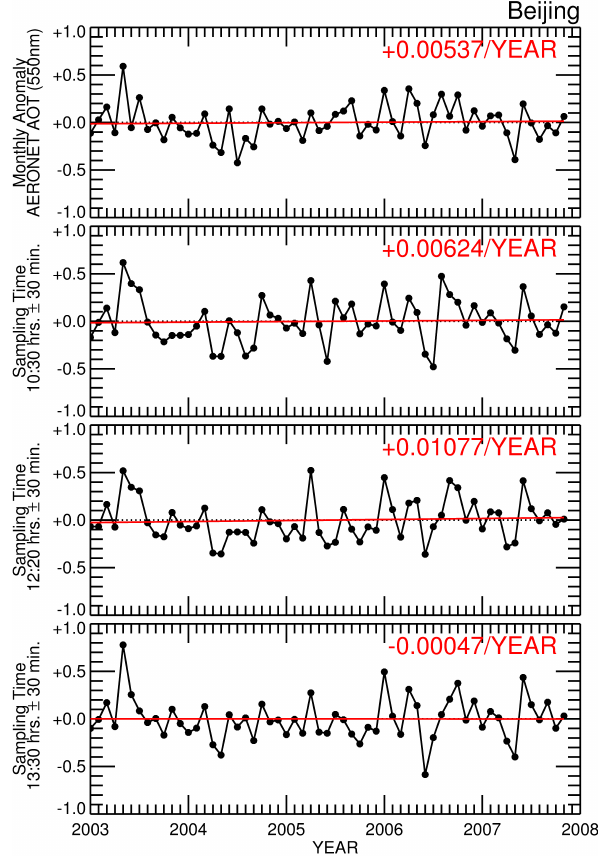
Figure 4. Time series of monthly anomaly of AERONET AOTs (550nm) (i.e. all available data or sampled at 10:30 hrs. ± 30 min., 12:20 hrs. ± 30 min., and 13:30 hrs. ± 30 min.) from 2003 to 2007 and corresponding trend estimates at Beijing station.